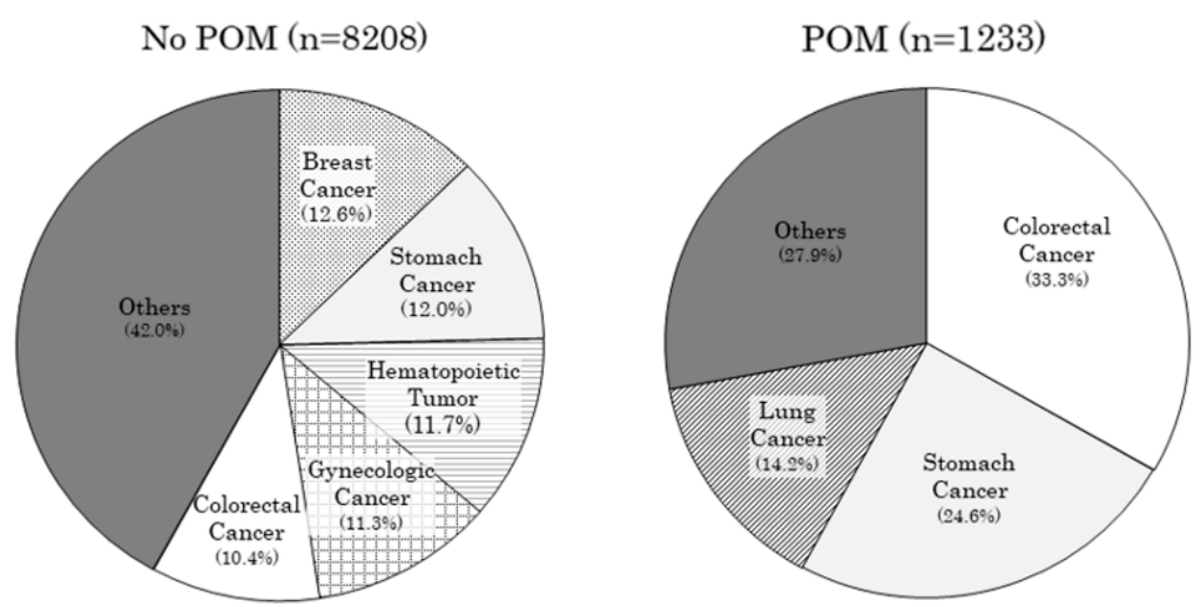
Figure 2. Comparison of the percentage of primary lesions in No POM and POM.